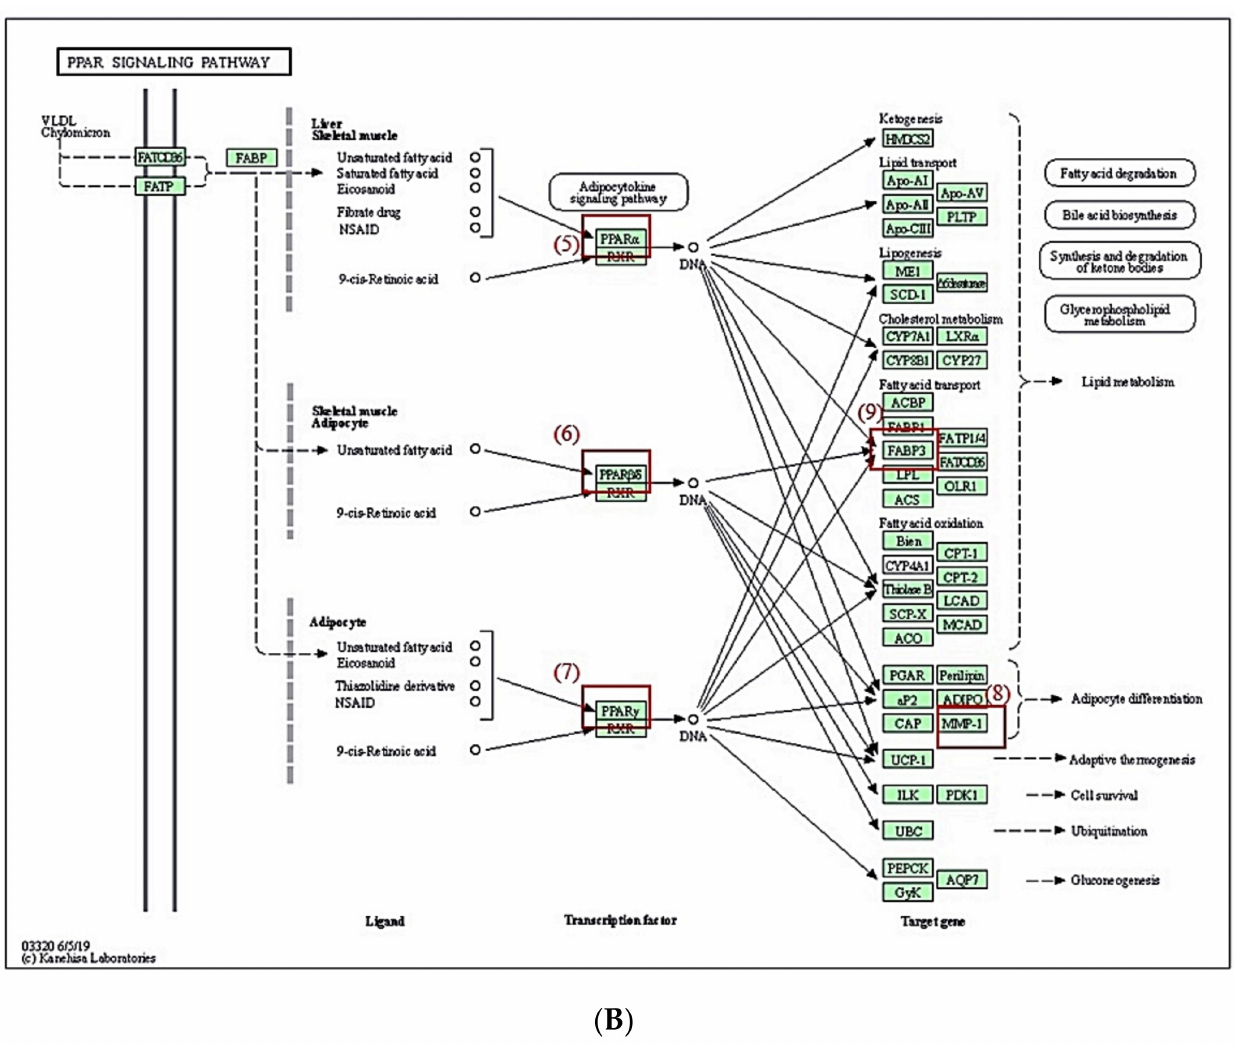
Figure 7. KEGG pathway enrichment map. ( A ) MAPK signaling pathway. ( B ) PPAR signaling pathway. Red rectangles represent key targets: (1) FGF1, FGF2, VEGFA; (2) TNFRSF1A; (3) PRKCA; (4) PLA2G4A; (5) PPARA; (6) PPARD; (7) PPARG; (8) MMP1; (9)